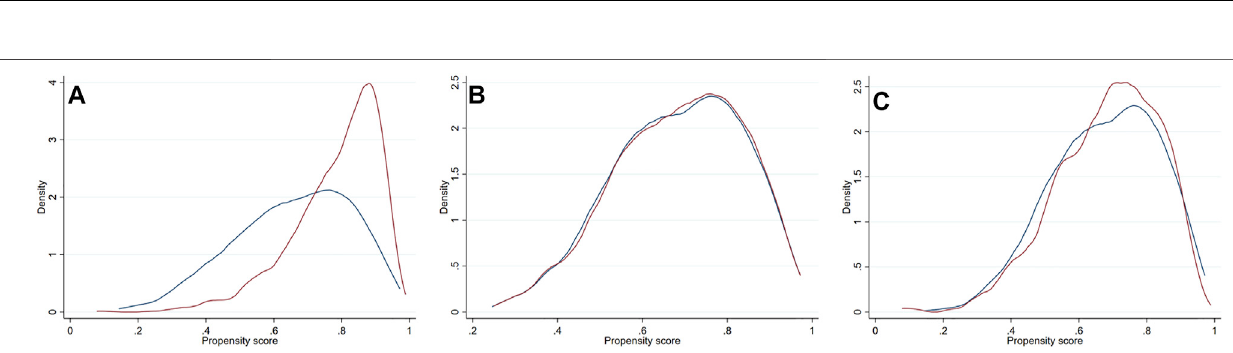
FIGURE 2 | Prognostic impacts of ACEI/ARB on various outcomes. ACEI = angiotensin converting enzyme inhibitors, ARB = angiotensin receptor blockers, HR = hazard ratio, CI = con fi dence interval, MI = myocardial infarction, PSM = propensity score matching, PSMW = propensity score matching weight.